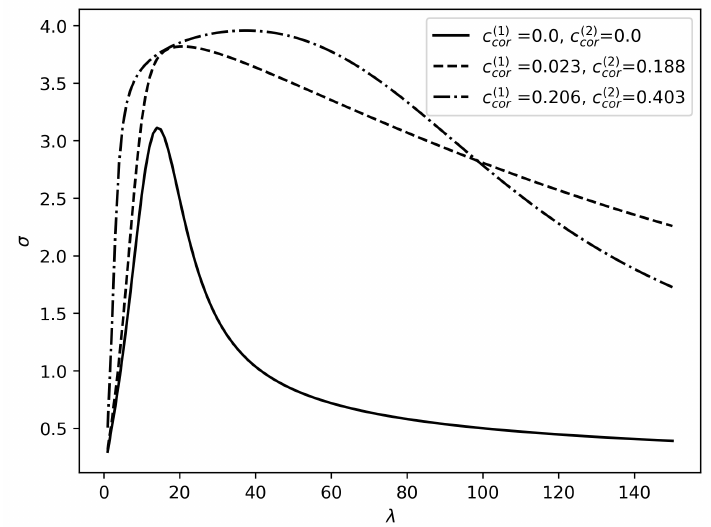
Figure 9. The standard deviations σ of the number of customers in the buffer for the BMMAP s with different coefficients of correlation.